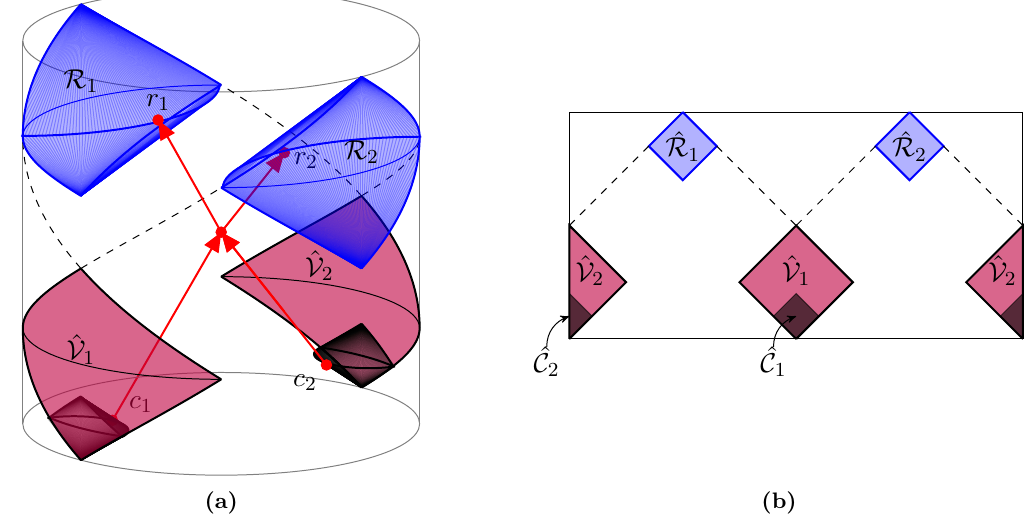
Figure 1. (a) Bulk perspective on a particular quantum task. The task has inputs given at bulk points c and c , and outputs are required at r and r . (b) Boundary view of the same task. Now 1 2 1 2 regions ˆ C whose entanglement wedge C contains point c become the input regions, while the ˆ R i i i whose entanglement wedge ˆ R contains the r become the output regions. Define the scattering i i region J E ≡ J + ( C 1 ) ∩ J + ( C 2 ) ∩ J − ( R 1 ) ∩ J − ( R 2 ) in the bulk geometry, and the decision regions 12 → 12